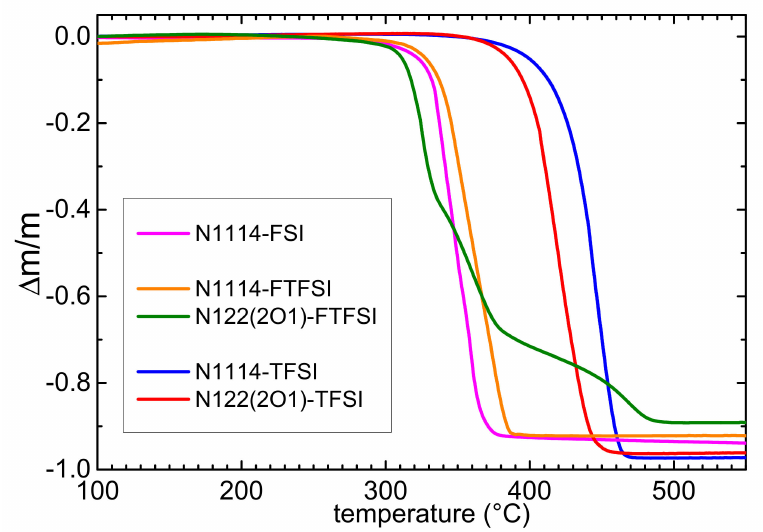
Figure 2. TGA curves of the investigated FTFSI-based ionic liquids in comparison with ILs containing the same cations and the FSI or TFSI